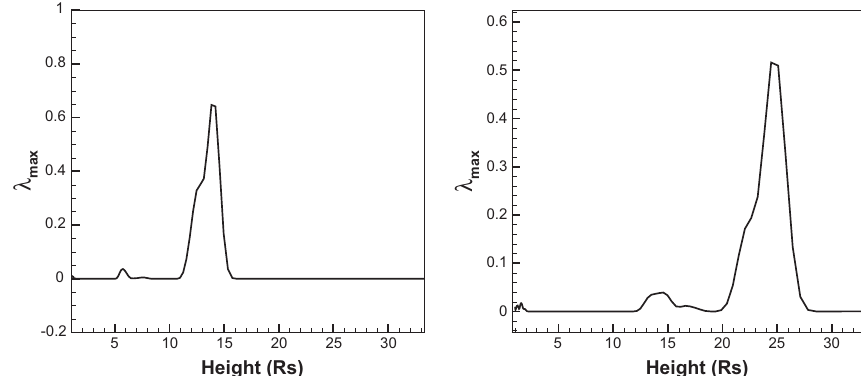
Fig. 7. Evolution of the spatial difference in the characteristic speed versus heliocentric